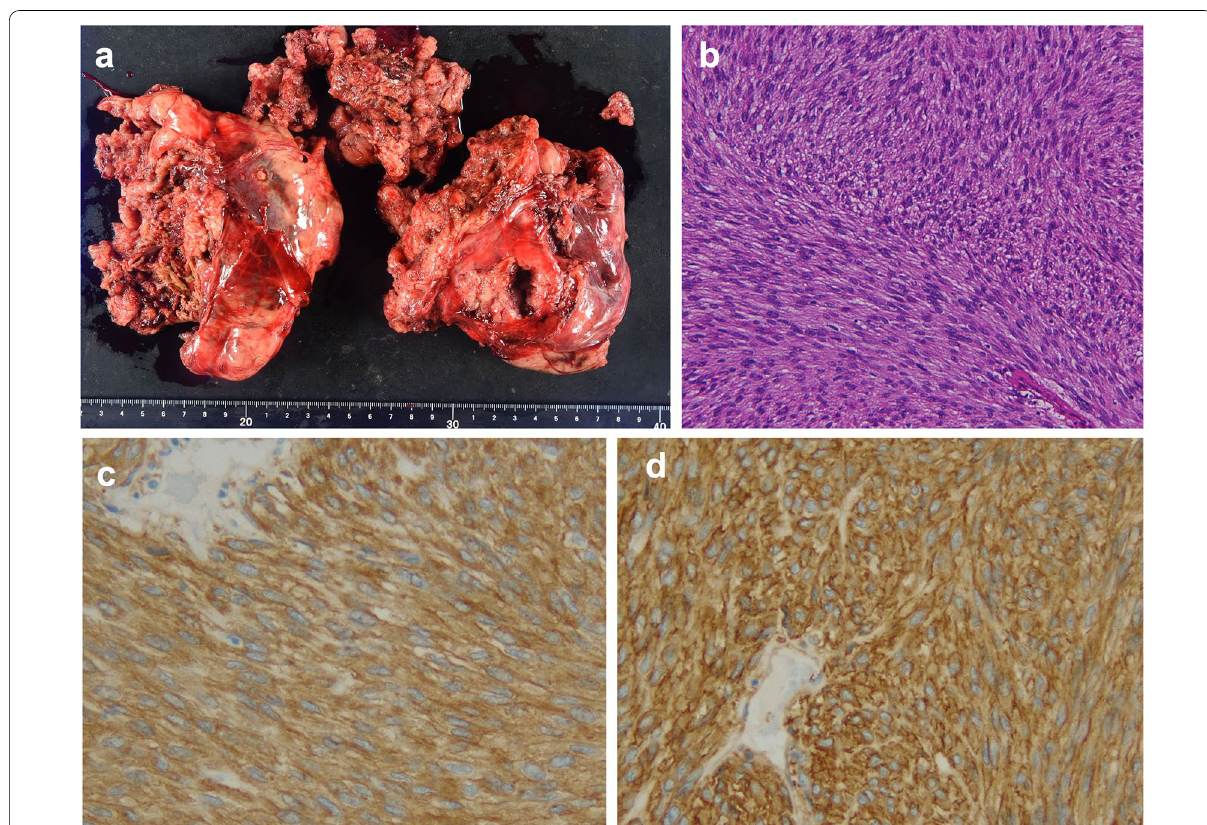
Fig. 3 a Macroscopic view of the resected tumor fragments, measuring approximately 19 fascicles of eosinophilic spindle cells (H&E